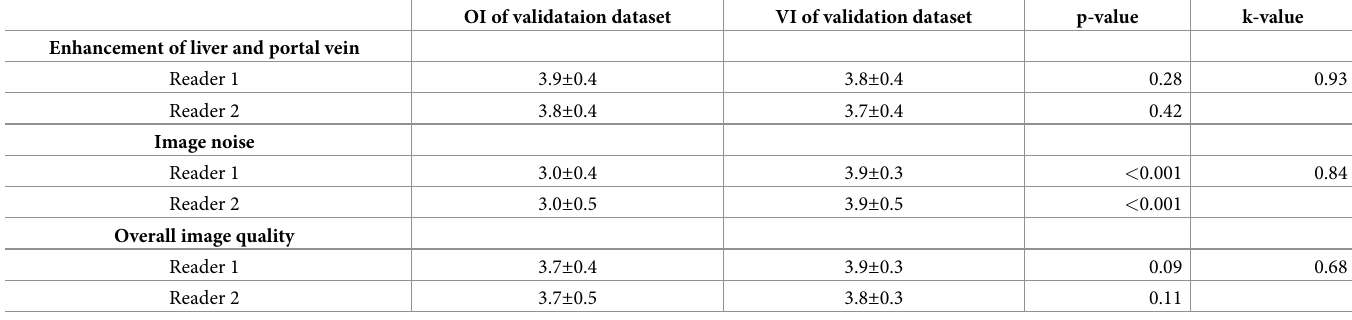
Table 4. Qualitative image analysis for validation dataset.